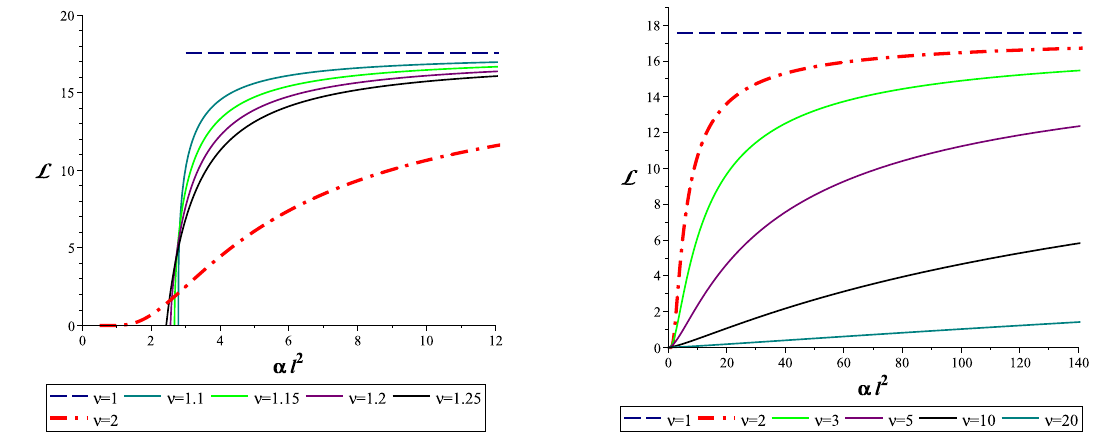
Figure 3 . We plot L ( (cid:11); (cid:23) ) for di(cid:11)erent (cid:12)xed values of (cid:23) by using the parametric expressions (3.6) and (3.7) in terms of x h , x h 2 [0 ;